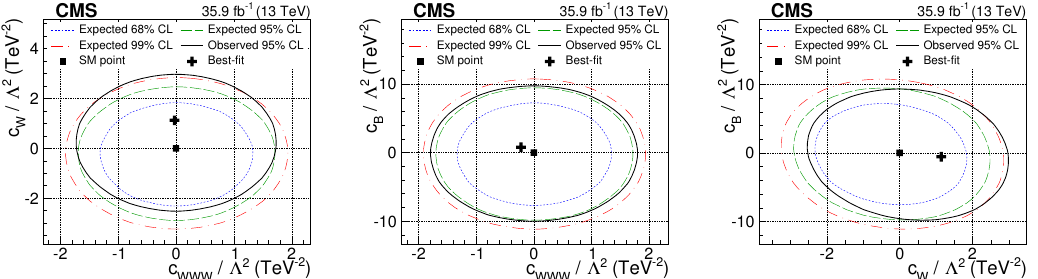
Figure 5 . Two-dimensional limits on the aTGC parameters in the EFT parametrization, for the combinations c = (cid:3) 2 { c = (cid:3) 2 (left), c = (cid:3) 2 { c = (cid:3) 2 (centre), and c = (cid:3) 2 { c = (cid:3) 2 (right). WWW W WWW B W B Contours for the expected 95% CL are shown in dashed green, with the 68 and 99% CL contours shown in dotted blue and dot-dashed red, respectively. Contours for the observed 95% CL are shown in solid black. The black square markers represent the SM expectation, while the black crosses show the observed best-(cid:12)t points.